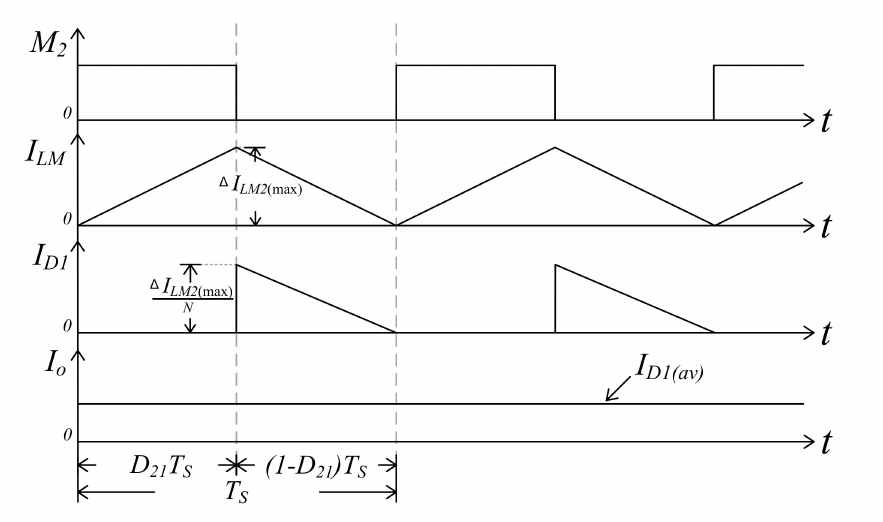
Figure 13. Conceptual waveforms of inductor current I Lm and output current I o in the